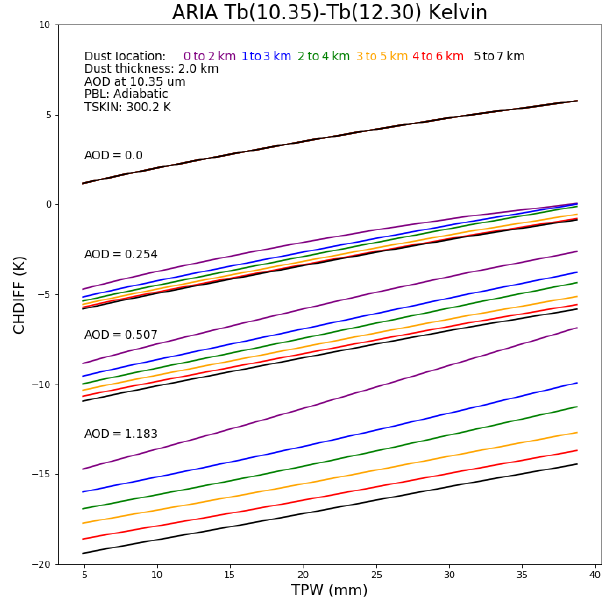
Figure 11. SWBTD channel difference (CHDIFF) for clear-sky conditions and for various configurations of dust layer optical thick- ness and dust height (ARIA dust type), shown as a function of column-integrated atmospheric moisture